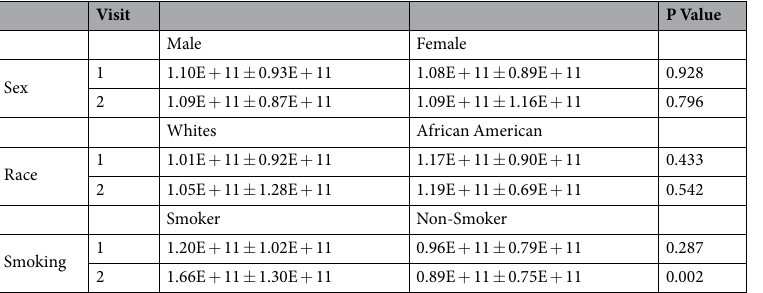
Table 2. EV concentrations by demographics. Average EV concentrations ± SD are indicated for different demographics. P values for likelihood ratio tests from linear mixed model regression accounting for matching by race and